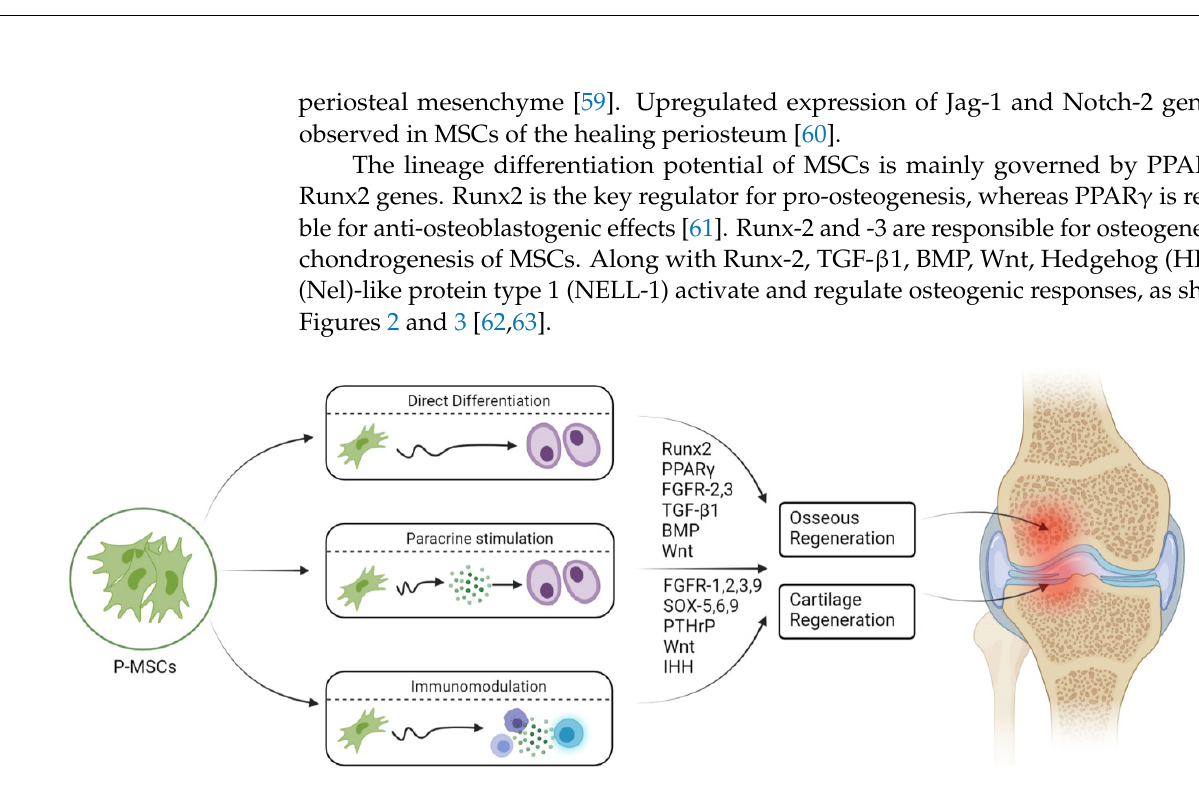
Figure 2. Osteogenic and chondrogenic differentiation of periosteal mesenchymal stem cells. Created with BioRender.com.